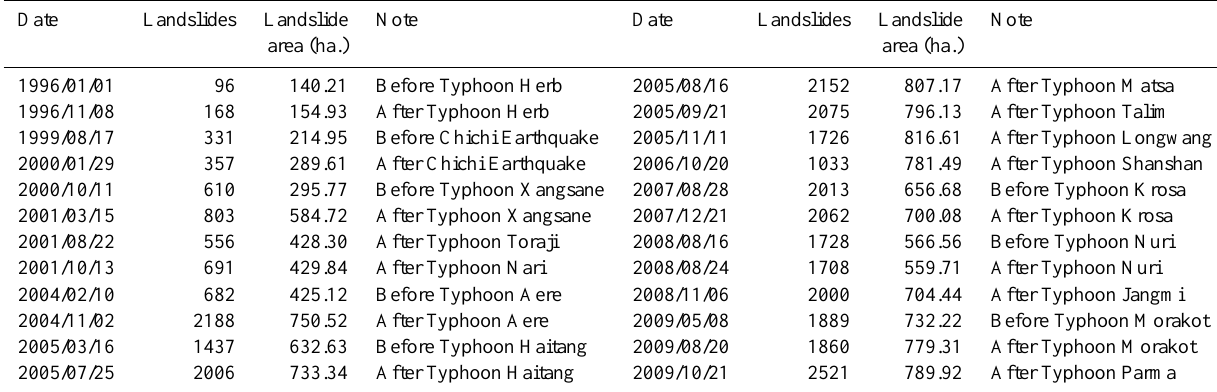
Table 1. The multi-year landslide inventory of the Shihmen